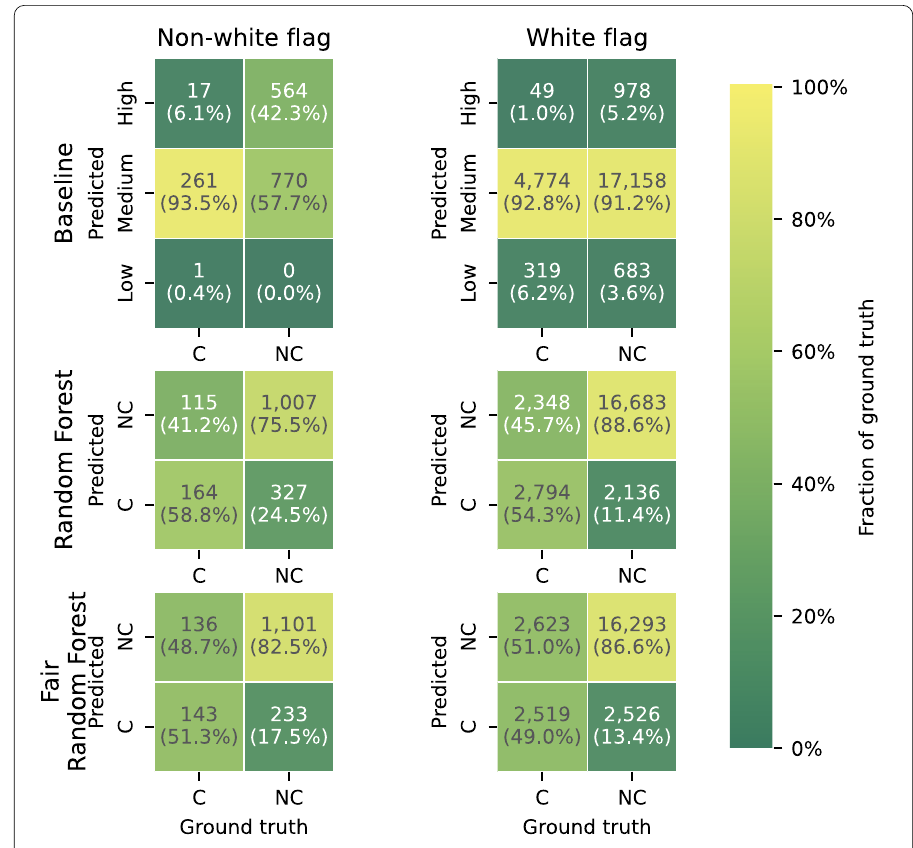
Figure 2 Confusion matrices for both the white and non-white flagged ships. The baseline model is the ship risk profile currently in use. C and NC mark compliant and noncompliant ships, respectively The percentages (and colour coding) are stratified based on the ground truth